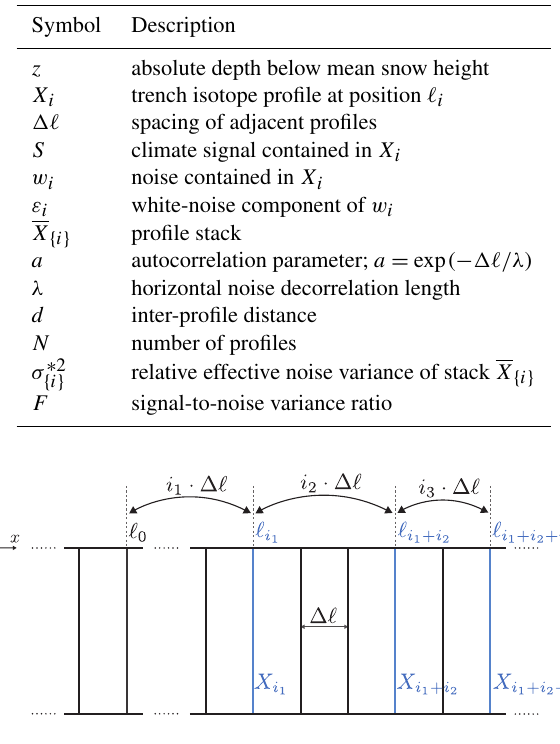
Table A1. Summary of the nomenclature used for the statistical noise model.